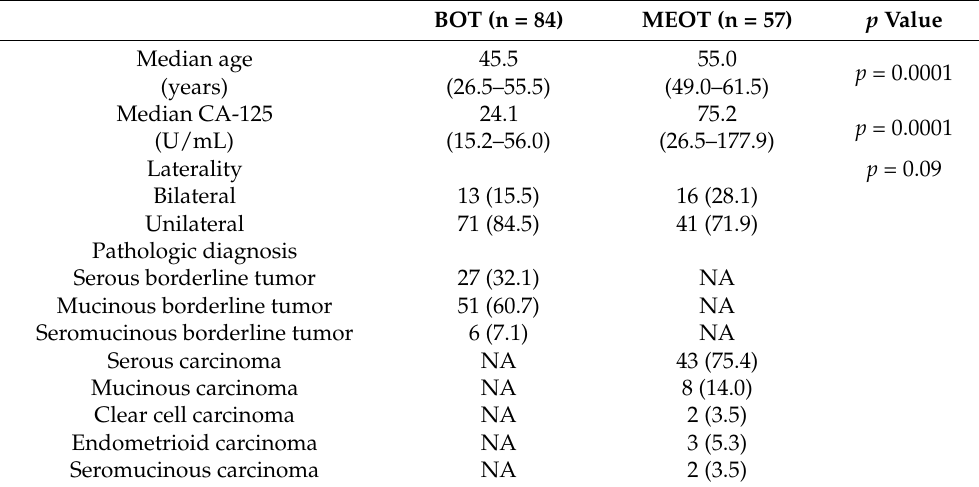
Table 1. Clinical and pathologic characteristics of patients.